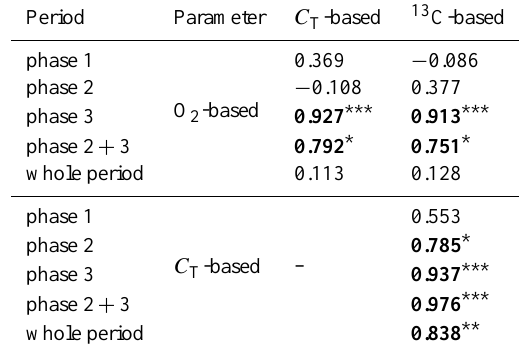
Table 3. Correlation analysis of NCP measured with three differ- ent methods: temporal changes of total carbon concentration ( C T - NCP) (Silyakova et al., 2012), net 13 C-POC production ( 13 C-NCP) (de Kluijver et al., 2012), and net oxygen production in incubation bottles (O 2 -NCP) (this study). The data were cumulated for each period: phase 1 ( t 8 to t 13), phase 2 ( t 14 to t 21), phase 3 ( t 22 to t 27), phase 2 + 3 ( t 14 to t 22), and the whole period ( t 8 to t 27). When NCP was not measured every day, the data were linearly interpolated before cumulation. Significant coefficients of correla- tion are shown in bold with * ( P < 0.05), ** ( P < 0.01), and *** ( P < 0.001) ( n = 9 for all cases). See also Fig. 4.